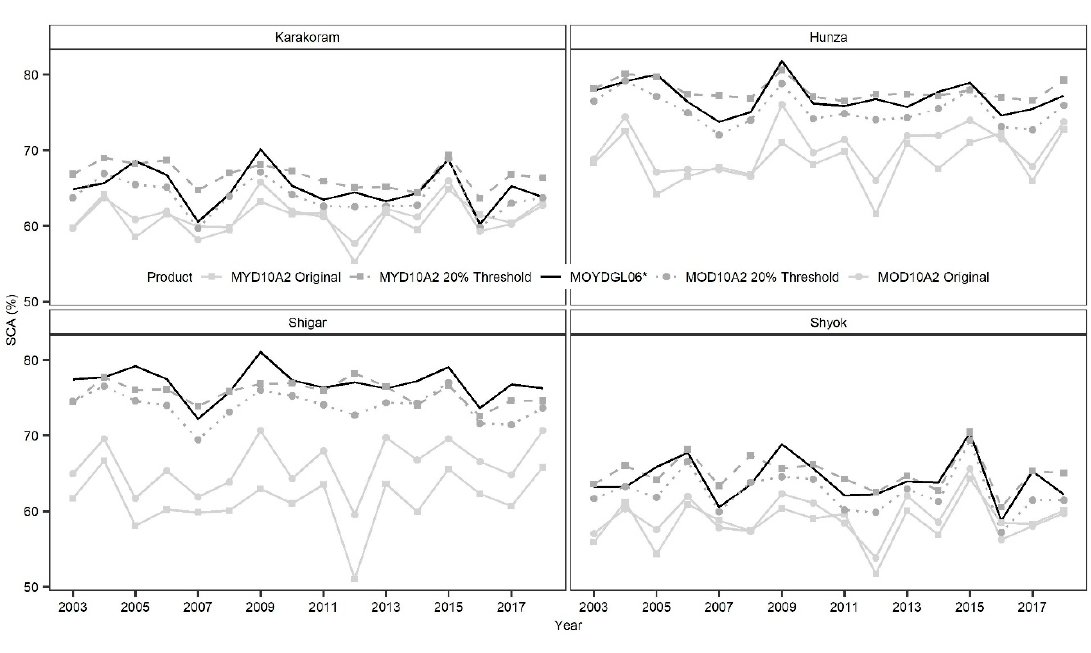
Figure 2. Time series of the mean annual snow cover area (SCA) from 2003 to 2018 using the original M*D10A2 and improved MOYDGL06* snow products. Table 2. Mean and standard deviation of annual average SCA (%) of the Karakoram region and subbasins using all the snow products.